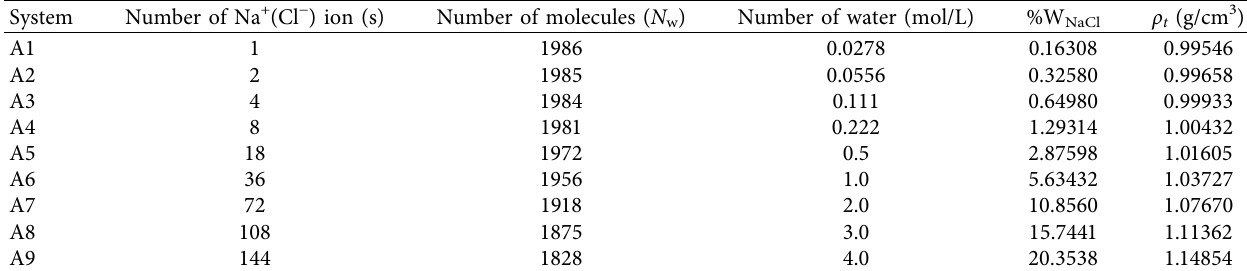
Table 2: The MD simulated systems in this